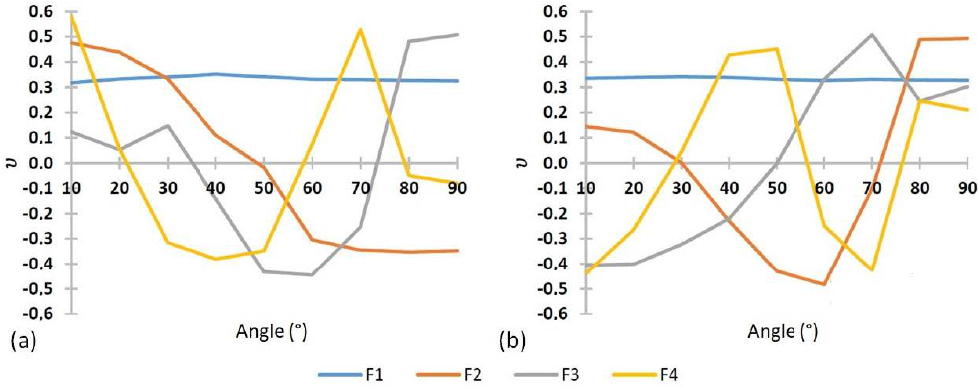
Figure 9. Representation of the first 4 eigenmodes for the two hands ( a ) H1 and ( b )